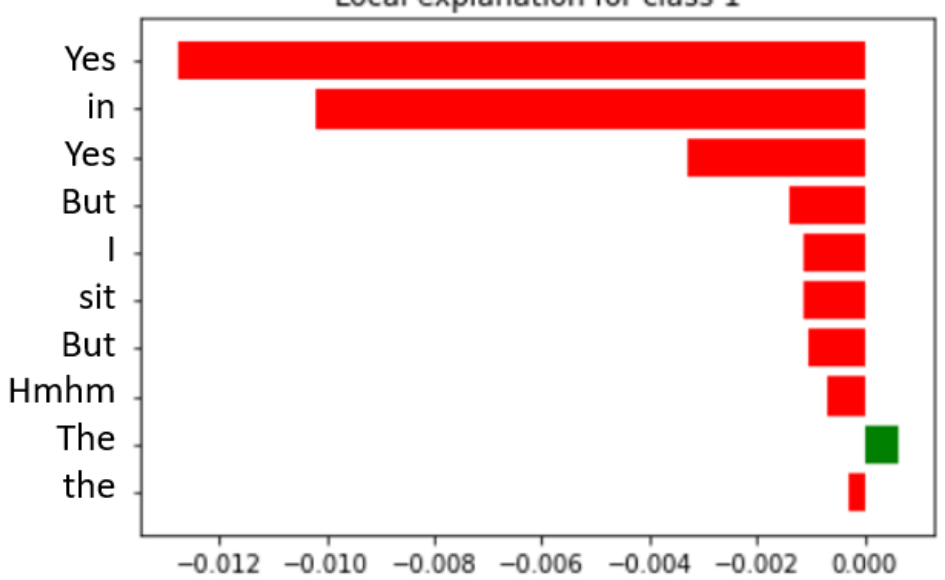
Figure 8. LIME explanation for quote 1 (top 10 words and how much they approximately contribute to the classification decision).